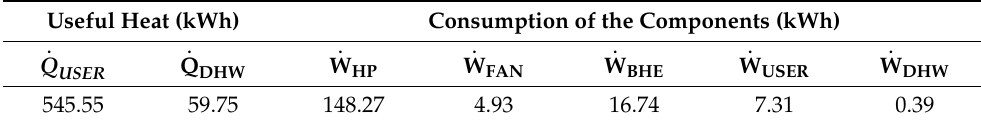
Table 12. Useful heat and consumption of the DSHP in summer in Strasbourg (year 15). Useful Heat